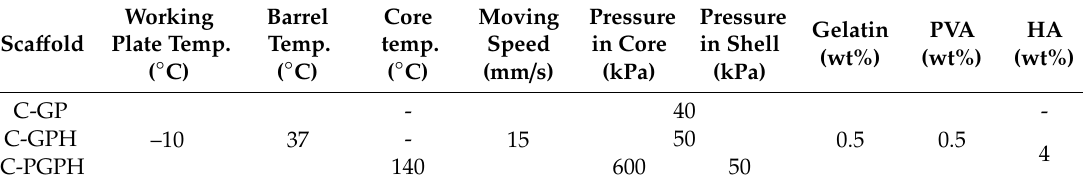
Figure 1. ( a ) Sca ff old modeling-(i) and a schematic for macro-porosity calculation-(ii). ( b ) Schematic illustration of the fabrication of C-GP, C-GPH and C-PGPH sca ff olds. Optical images and cross-sectional and surface scanning electron microscope (SEM) images of the fabricated sca ff olds: ( c ) C-GP, ( d ) C-GPH and ( e ) C-PGPH. Table 1. Processing parameters for sca ff old